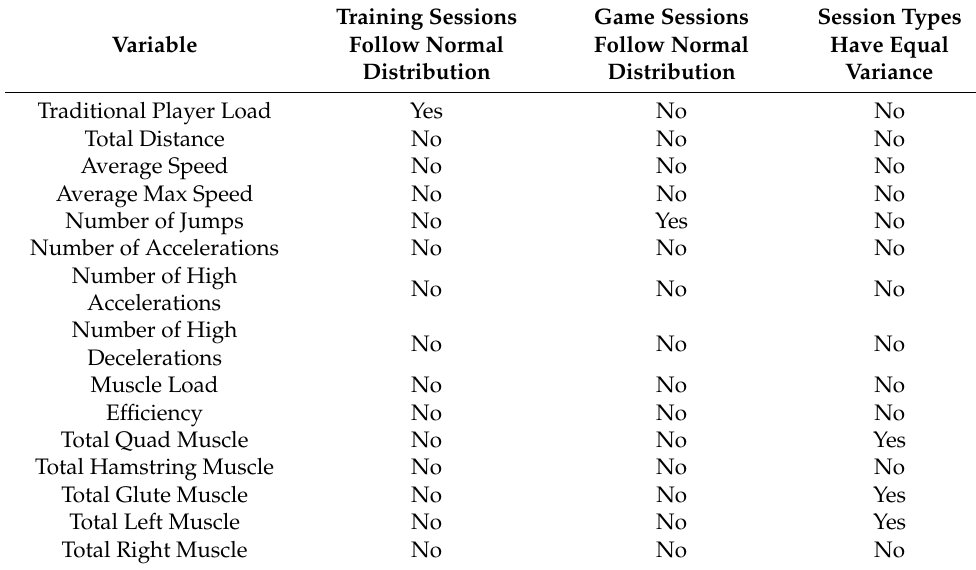
Table 2. Table of variables not meeting assumptions required for analysis of variance (ANOVA). Variable